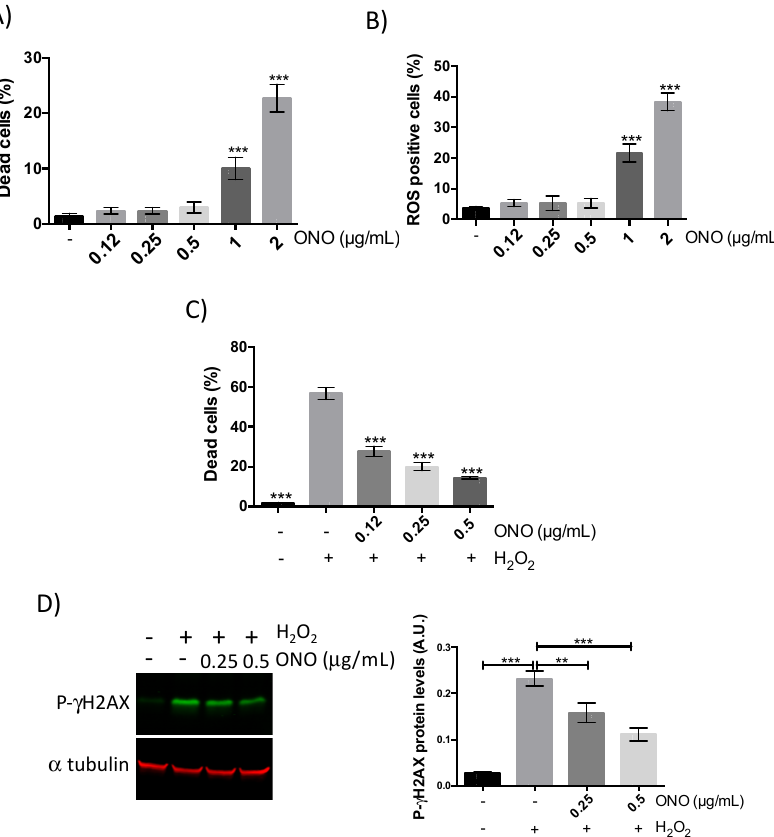
Figure 3. Onopordopicrin has a strong antioxidant activity on human muscle cells. Cell death ( A , C ) and reactive oxygen species (ROS) ( B ) quantification (percentage of all cells) in human myoblasts treated with onopordopicrin (ONO) at indicated concentrations prior to incubation with lethal concentration of H 2 O 2 ; ( D ) human myoblasts treated with onopordopicrin (ONO) at indicated concentrations prior to incubation with sub-lethal concentration of H 2 O 2 . On the left, Western blot analysis of phosphorylated γ H2AX protein level; on the right, quantification of the Western blot data, A.U. for arbitrary unit represents the ratio of p - γ H2AX protein level on α tubulin protein level. All data represent the means ± SD of three independent experiments; p < 0.01 (**) p < 0.001 (***) compared with H 2 O 2 in A, B and C (one-way ANOVA).